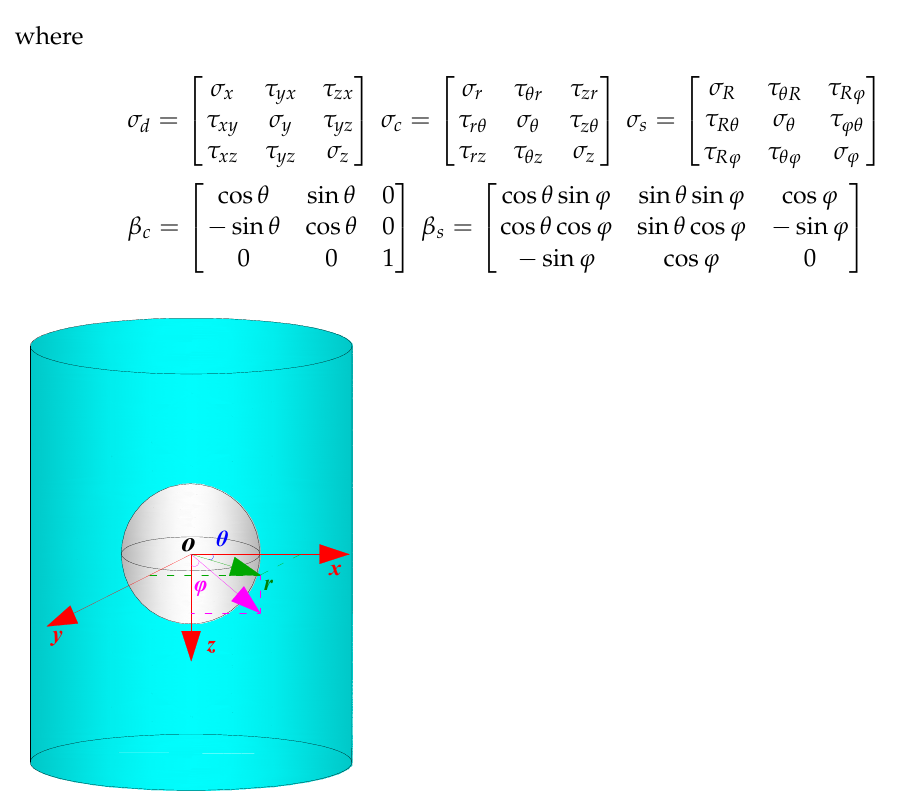
Figure 7. Sketch of relationship among different coordinates.